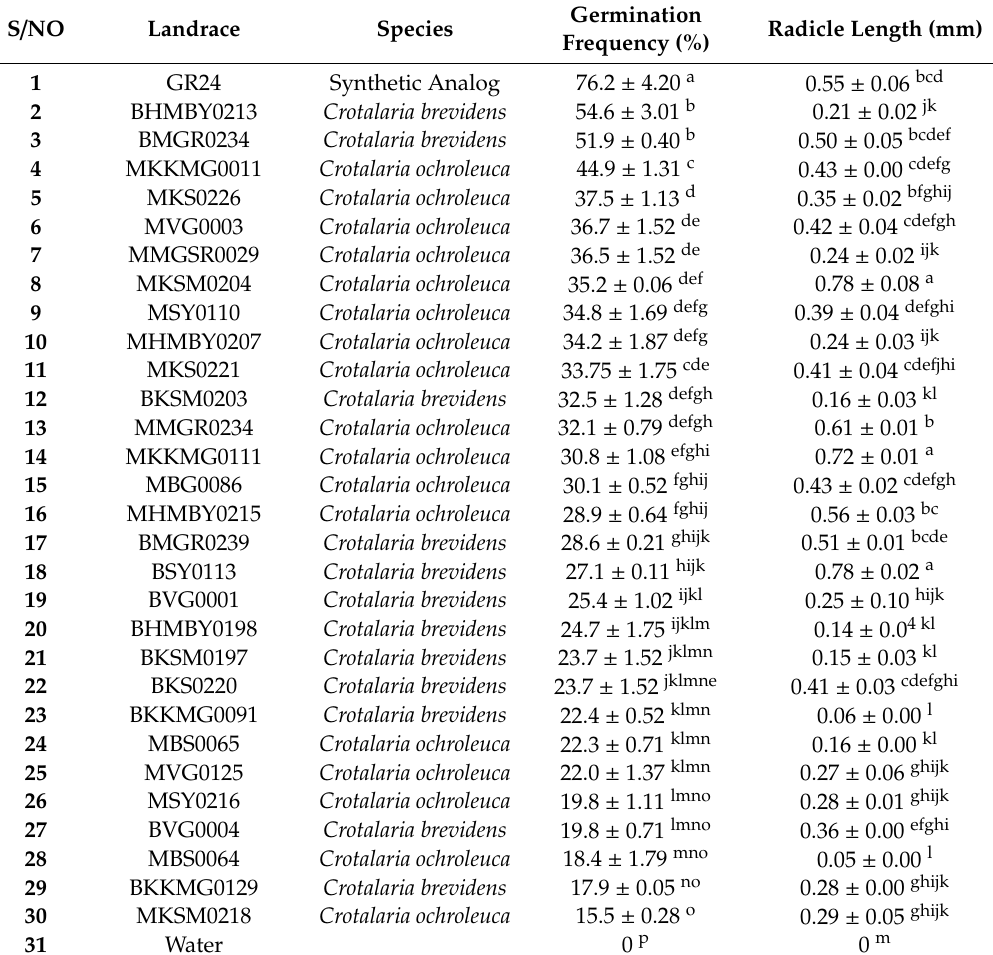
Table 1. Stimulation of Striga seed germination by Crotolaria determined using germination frequencies and radicle lengths of germinated Striga